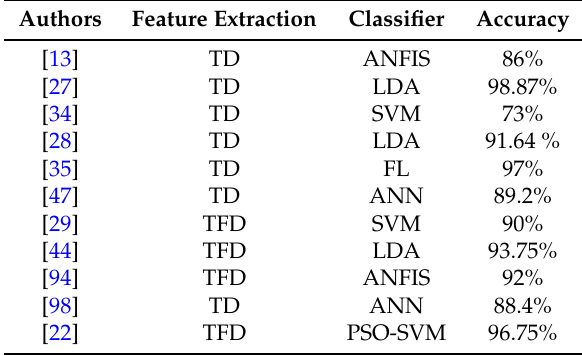
Table 7. Comparison of classification